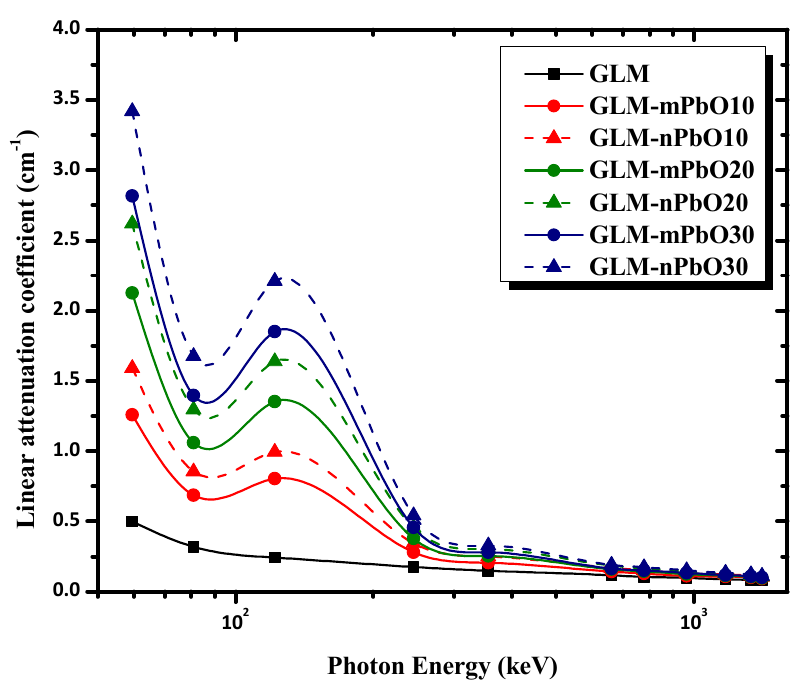
Figure 4. Linear attenuation coefficients for micro- and nano-PbO mortars as a function of photon